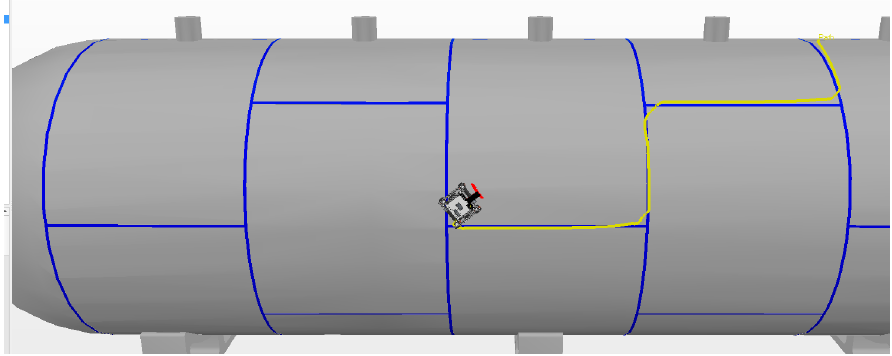
Figure 30. Emphasis on a curve where difficulties were